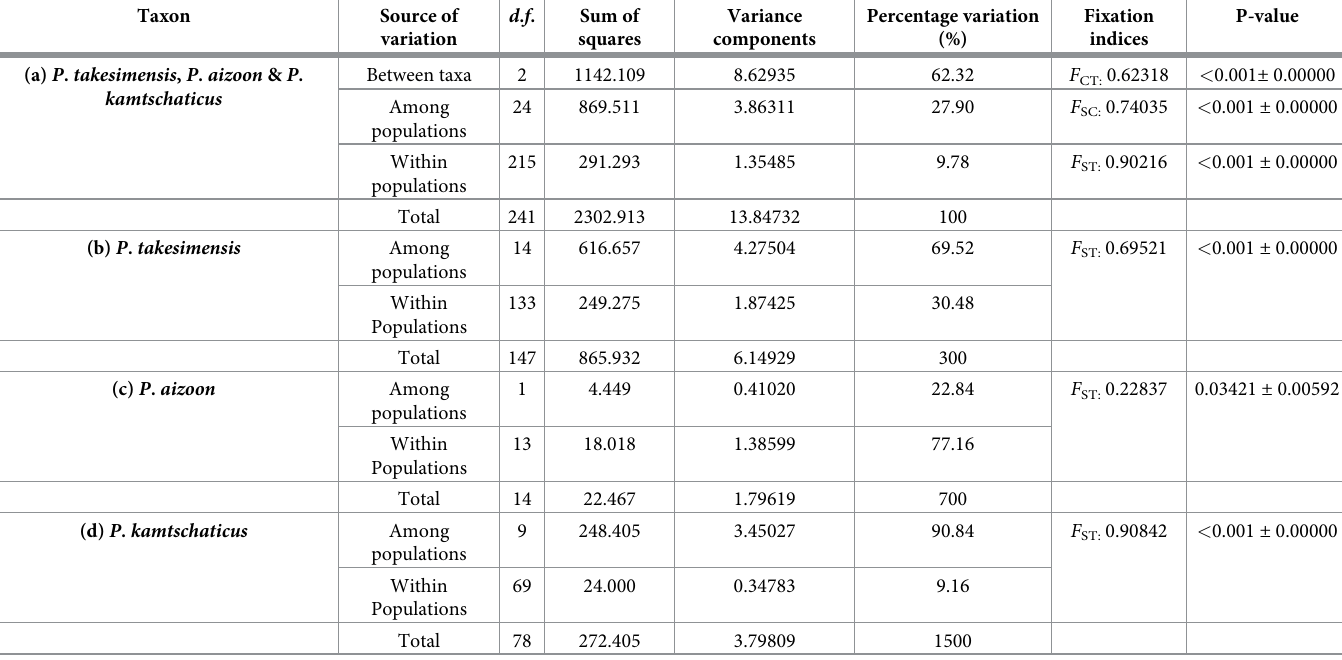
Table 4. Summary of the analysis of molecular variance (AMOVA) for genetic differences between three Phedimus species ( P . takesimensis , P . aizoon , and P . kamtschaticus ).